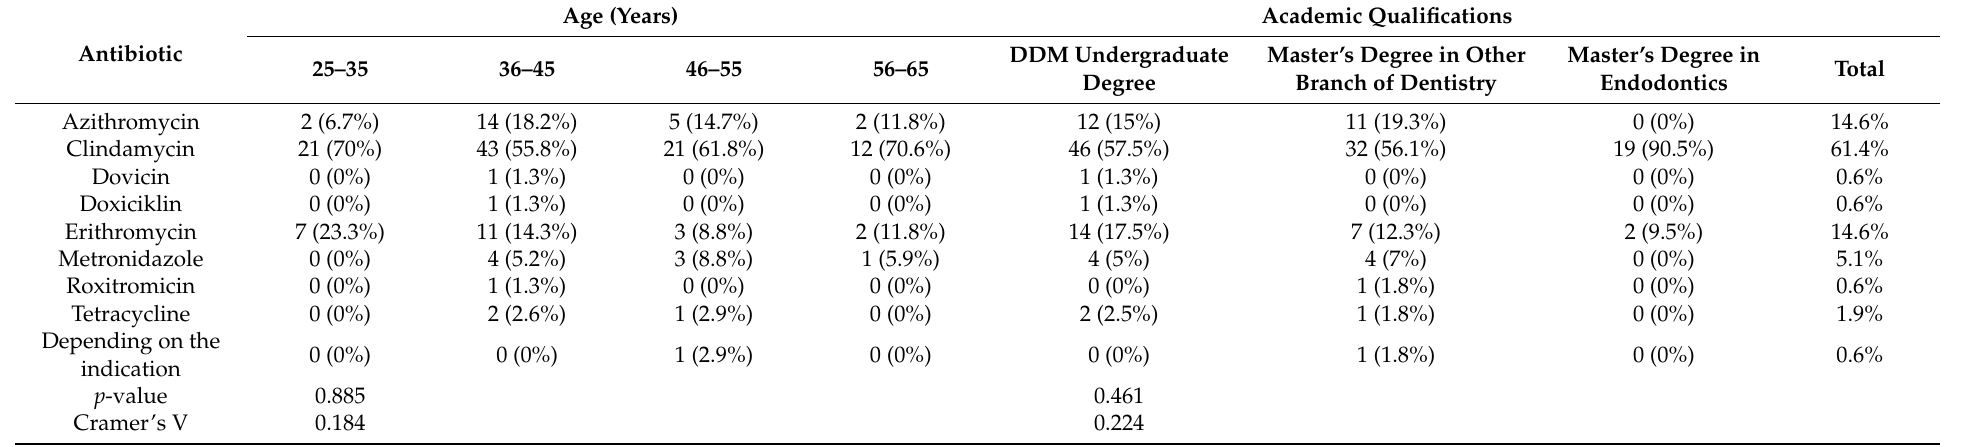
Table 3. Antibiotics of choice for patients allergic to penicillin according to the participants’ age and academic qualifications.